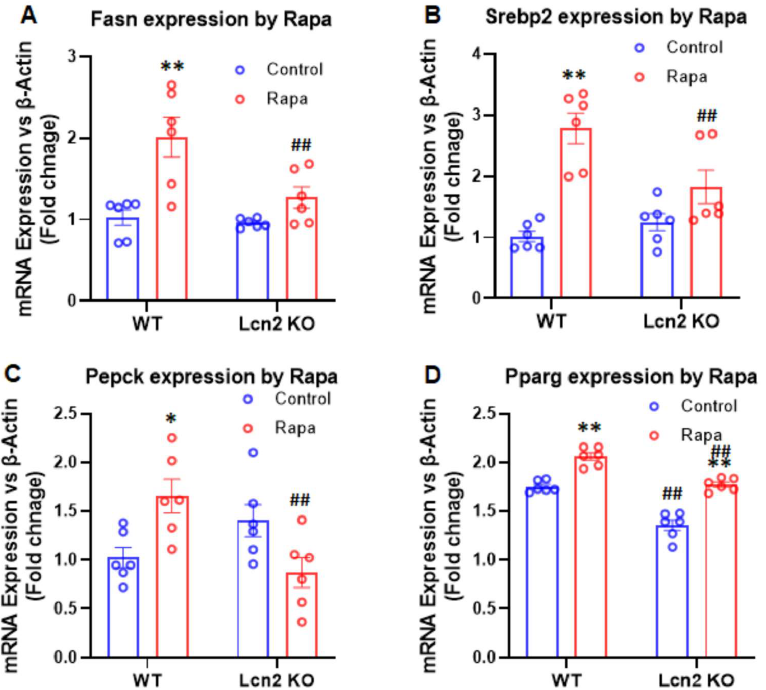
Figure 6. Effect of mTORC1 inhibition by rapamycin on lipogenesis gene expression in inguinal adipocytes ( A – D ). Results are presented as mean ± SEM ( n = 6 for ( A – D )). * p < 0.05, ** p < 0.01 versus controls. # p < 0.05, ## p < 0.01 versus WT adipocytes.